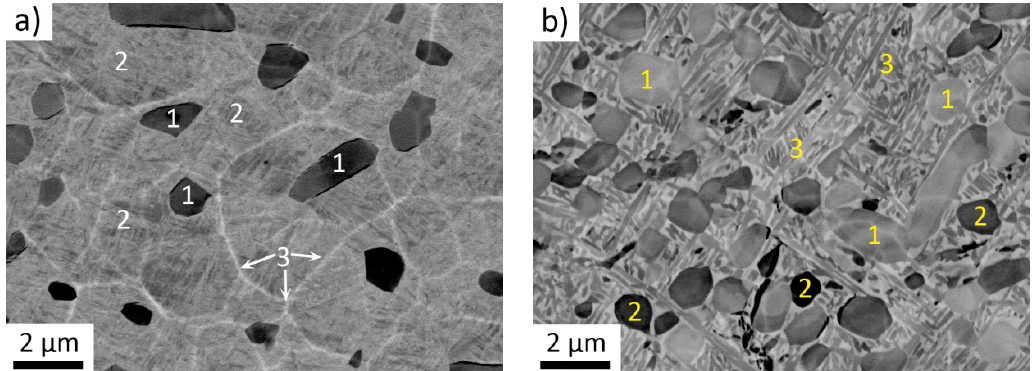
Figure 3. Duplex microstructures of Zr-4Sn-4Nb alloy ( a ) forged , containing primary α phase particles (1) and surrounding regions of α ’ martensite (2); lighter areas caused by ion polishing (3); ( b ) forged + aged , containing primary alpha phase (1 and 2), surrounded by α + β lamellar regions (3).